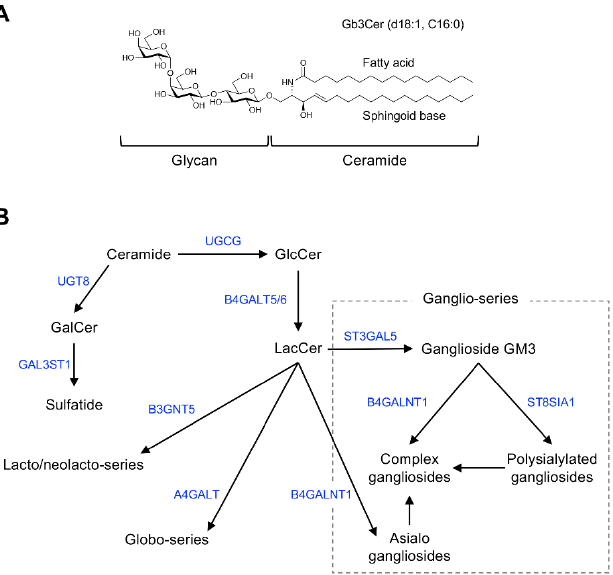
Figure 1. Chemical structure and mammalian glycosphingolipid (GSL) biosynthetic pathway. ( A ) Chem- ical structure of a typical mammalian GSL, globotriaosylceramide (Gb3Cer), shown as an example. ( B ) Arrows and blue font indicate biosynthetic pathway and catalytic enzymes, respectively. Abbreviations: GlcCer, Glc β 1,1Cer; GalCer, Gal β 1,1Cer; LacCer, Gal β 1,4Glc β 1,1Cer; GM3, Sia α 2,3Gal β 1,4Glc β 1,1Cer; UGCG, UDP-glucose ceramide glucosyltransferase; UGT8, UDP glycosyltransferase 8; GAL3ST1, galactose-3- O -sulfotransferase 1; B4GALT5/6, β -1,4-galactosyltransferase 5/6; B3GNT5,